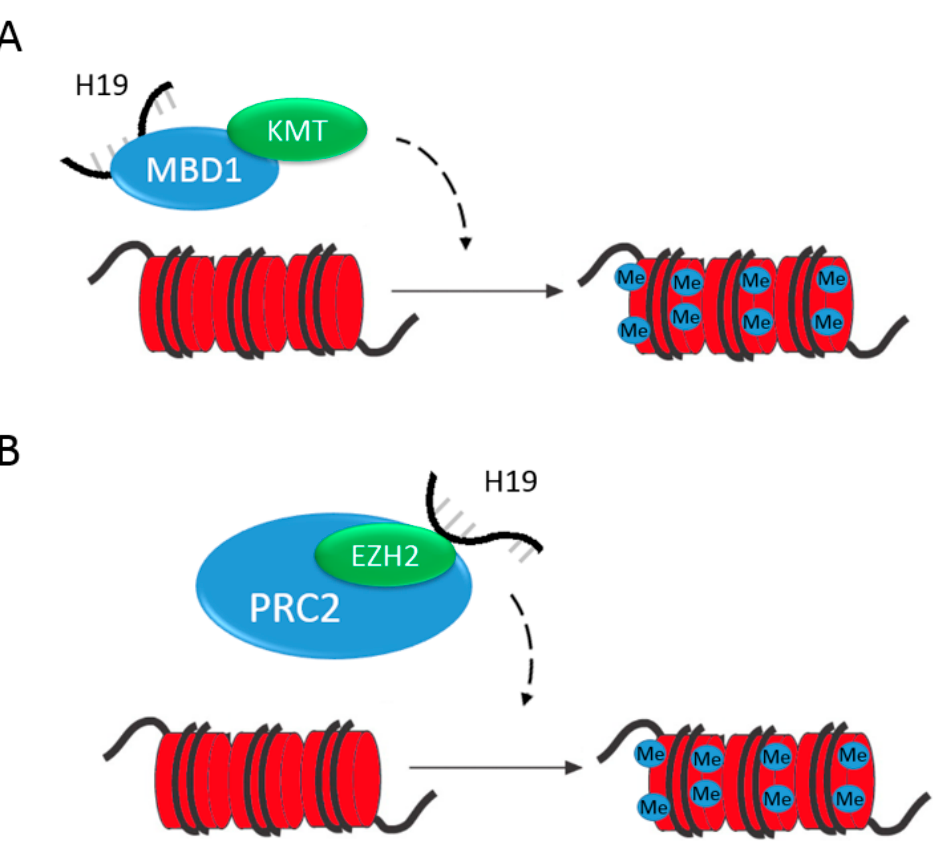
Figure 2. Epigenetic regulation by H19. H19 acts to repress genes within the imprinted gene network, such as IGF2 . H19 binds MBD1. MBD1 then binds methylated DNA and then recruits histone lysine methyltransferases (KMTs) to silence these genes by chromatin compaction ( A ). H19 silences E-cadherin. H19 binds EZH2, a H3K27 methyltransferase part of the PRC2, causing downregulation of E-cadherin ( B ).